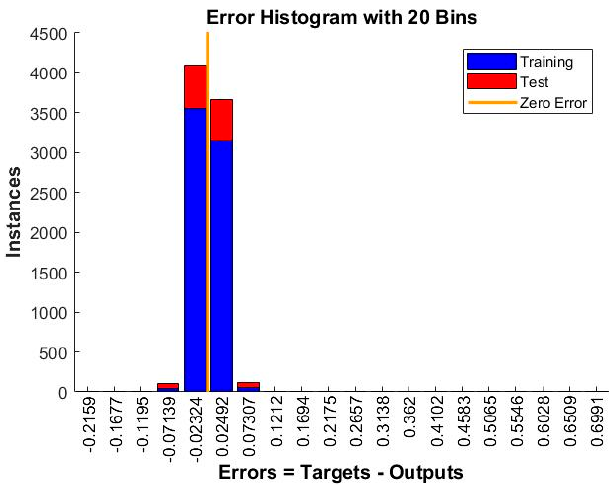
Figure 16. The error histogram when forecasting the electricity consumption for the month of December, using the ANN_NARX_BR_TS network.